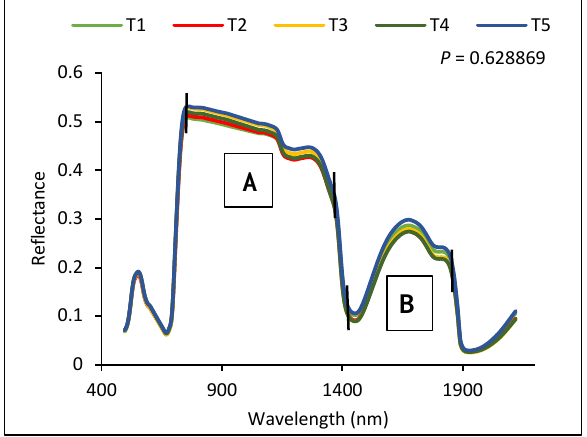
Figure 3. Reflectance Curves of Different Treatment Levels